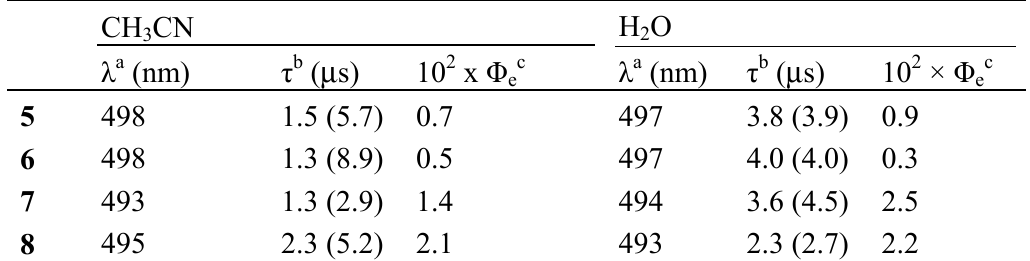
Table 2. a Band maximum for the highest energy peak, uncorrected spectra. c Quantum yields obtained from corrected